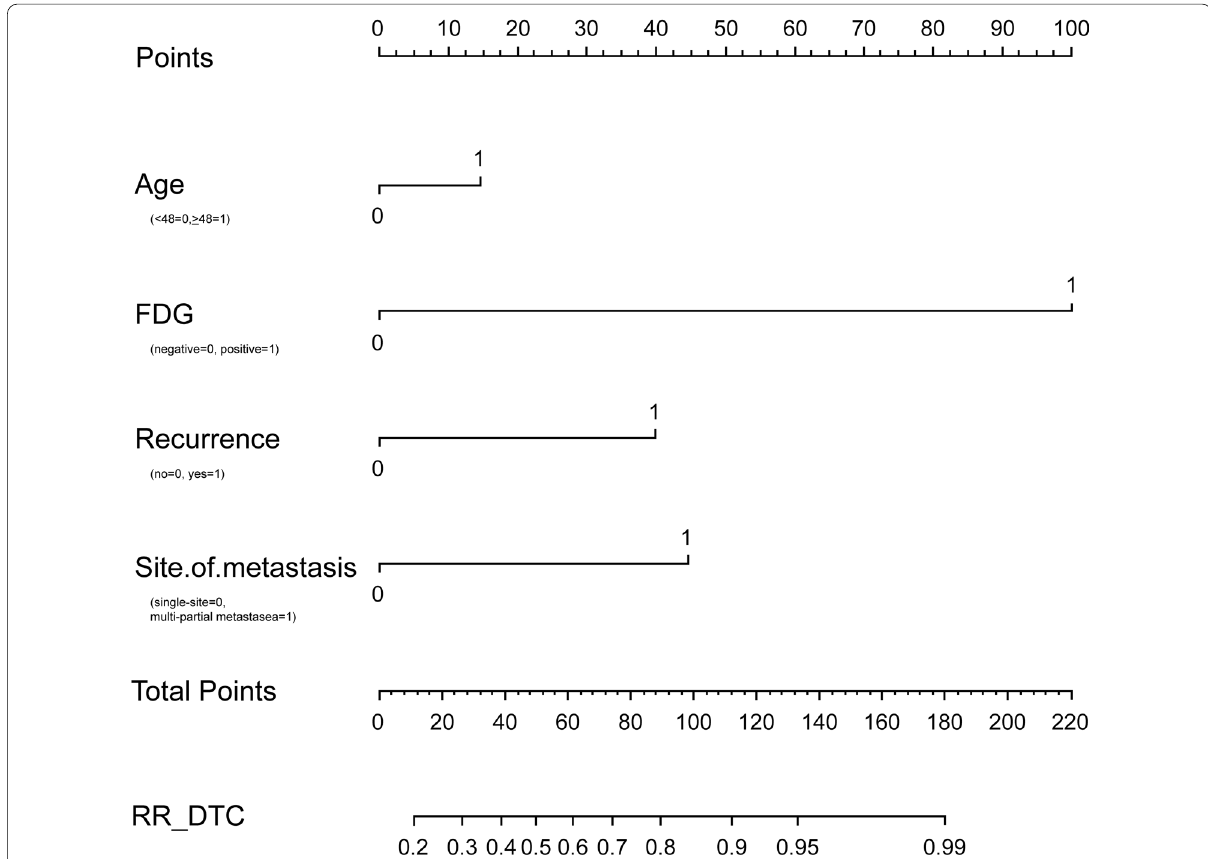
Fig. 7 Nomogram predicting the probability of occurrence of RR-DTC. Age (0: < 48,1: the operation and iodine-131 treatment (0: no, 1: yes), site of metastasis (0: single-site, 1: multi-partial metastases). 18 F-FDG, 18 F-fluorodeoxyglucose; RR-DTC, radioiodine refractory differentiated thyroid carcinoma